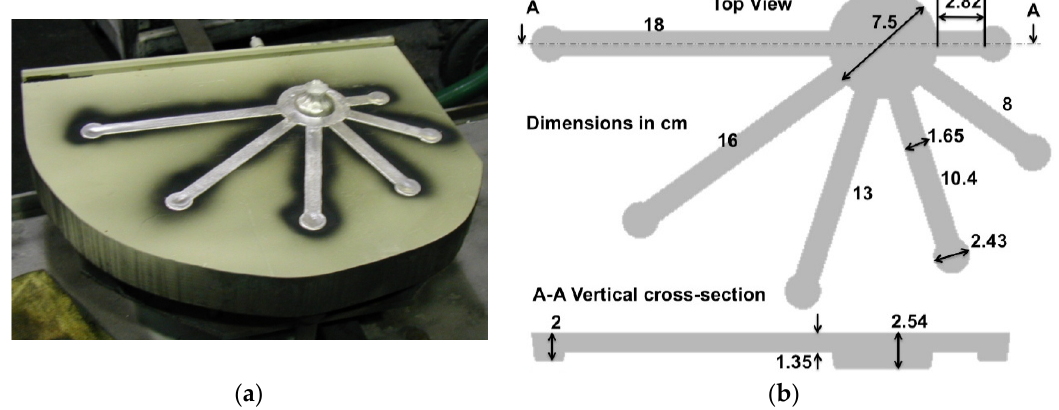
Figure 1. Multi-arm casting in permanent mold for hot-tearing assessment: ( a ) photo, and ( b ) geometry details and dimensions [cm].